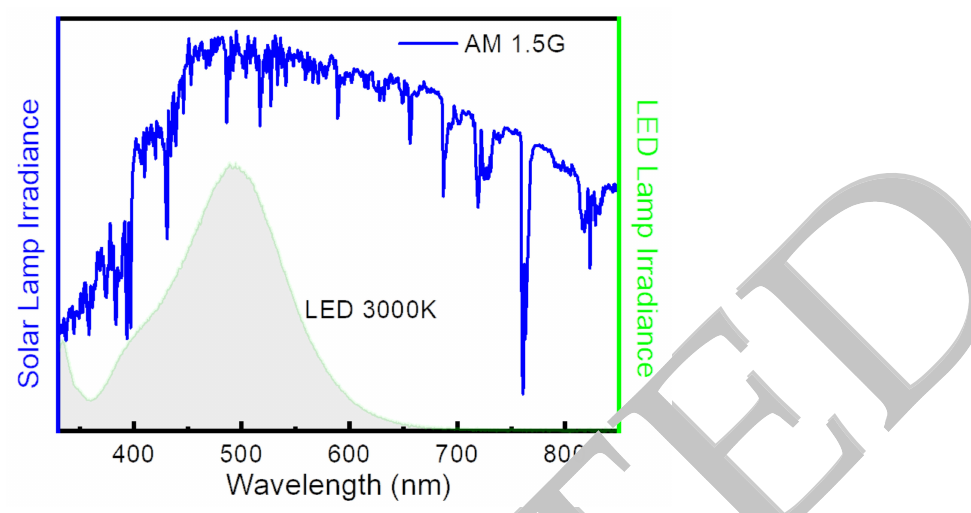
Figure 1. The spectral irradiance of the outdoor (1-sun) and indoor (LED 3000 K) light